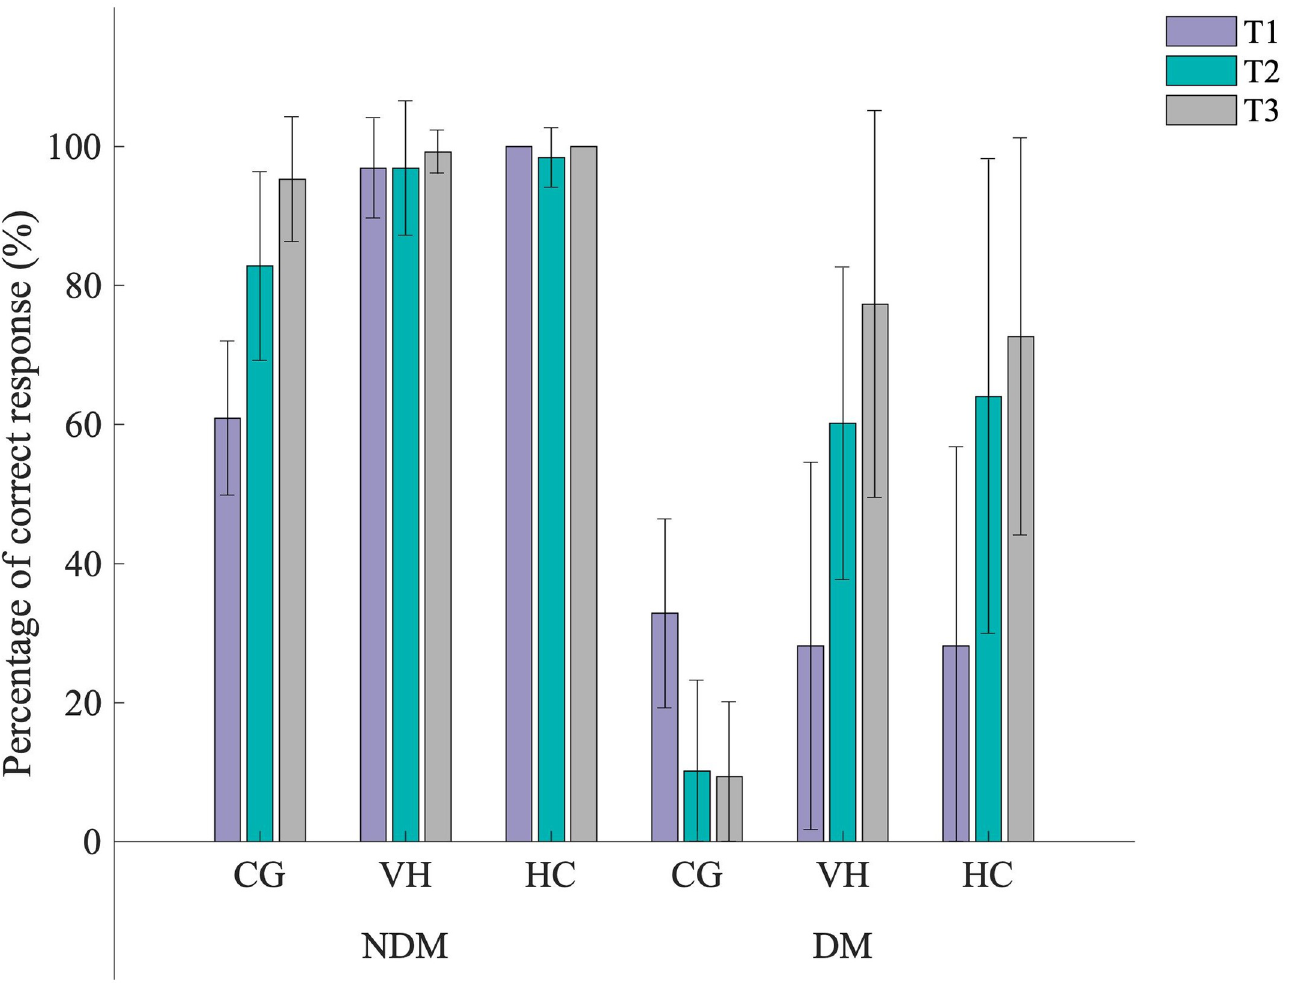
Fig 4. Interaction between appearance, motion and cut off times during the perception task. Mean ± SD percentage rate of success for the interaction between appearance, motion and cut off times during the perception